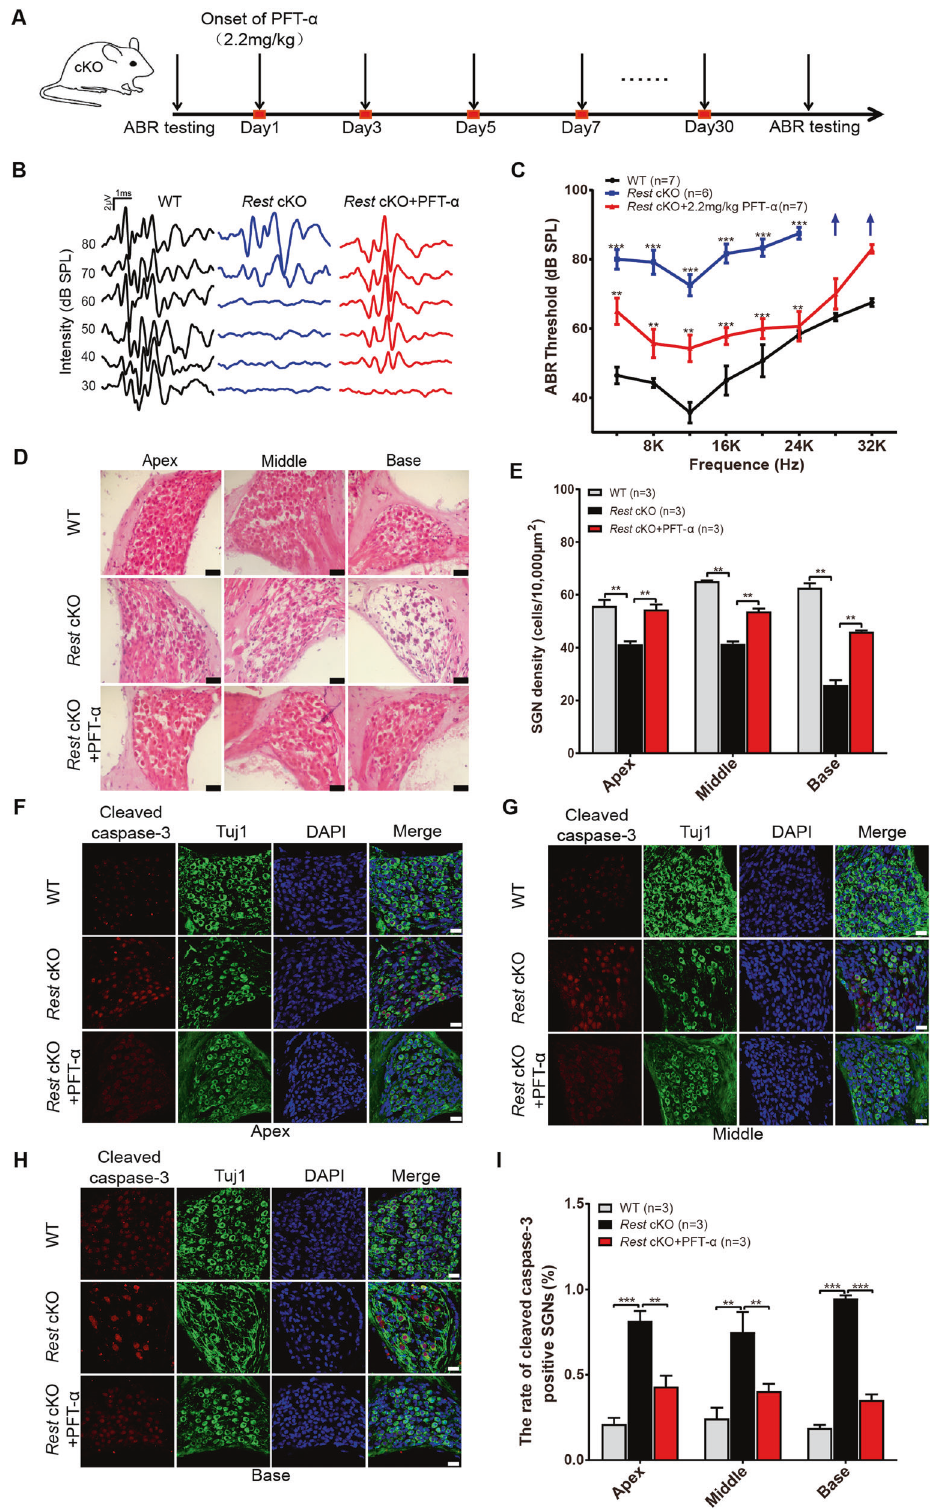
Fig. 5 p53 inhibitor pi fi thrin- α rescues the hearing loss in Rest cKO mice. A Timeline for ABR testing and drug treatment. Pi fi thrin- α was administered to 2-month-old Rest cKO mice at 2.2 mg/kg every other day, for 30 days. B Representative ABR waveforms were shown in WT, Rest cKO, and Rest cKO + pi fi thrin- α (PFT- α ) mice. C ABR thresholds of WT and Rest cKO mice are treated with pi fi thrin- α . Arrows indicate when the threshold exceeded the upper limits of TDT ABR system. D , E Morphometry of SGNs in WT, Rest cKO, and Rest cKO + pi fi thrin- α mice. Scale bar: 20 µm. F – I Expression of cleaved caspase-3 in SGNs of apex, middle and base of cochlea from WT and Rest cKO mice. Scale bar: 20 µm. Data are represented as mean ± SEM. ** P < 0.01, *** P < 0.001.